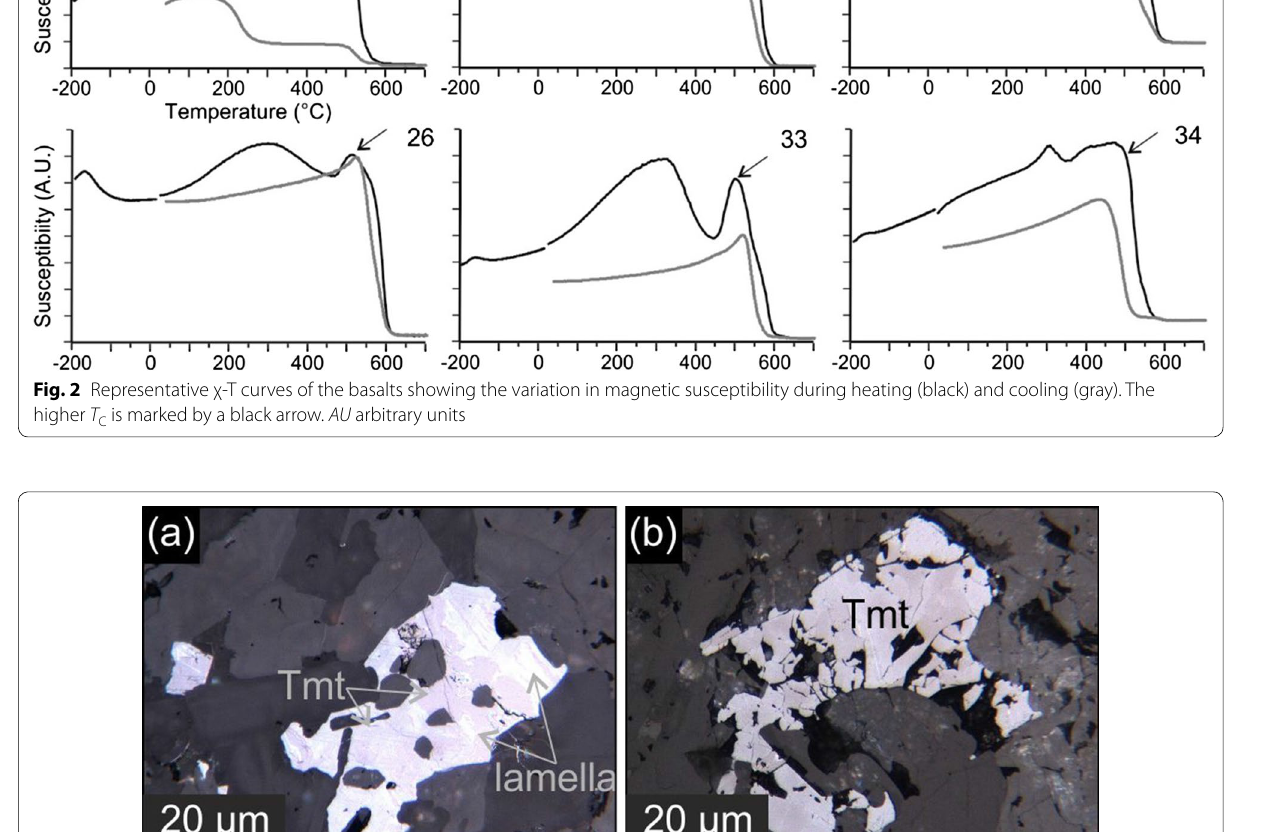
ples dominated by MD with MDF